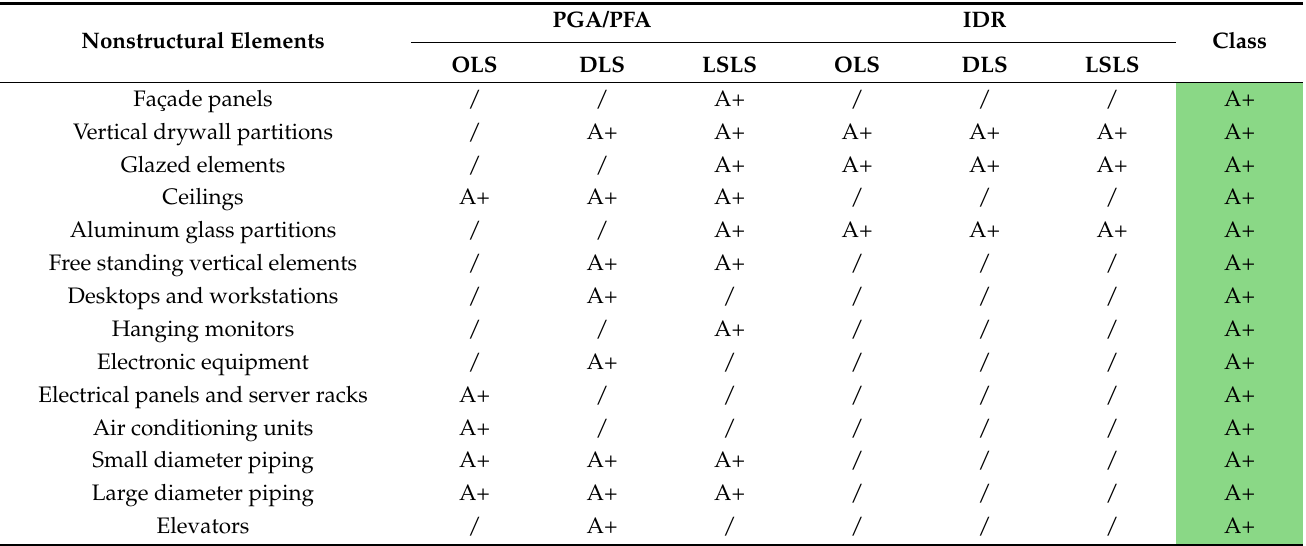
Table 12. Seismic risk classes for the nonstructural elements located at the higher level of unit A of the case study building.